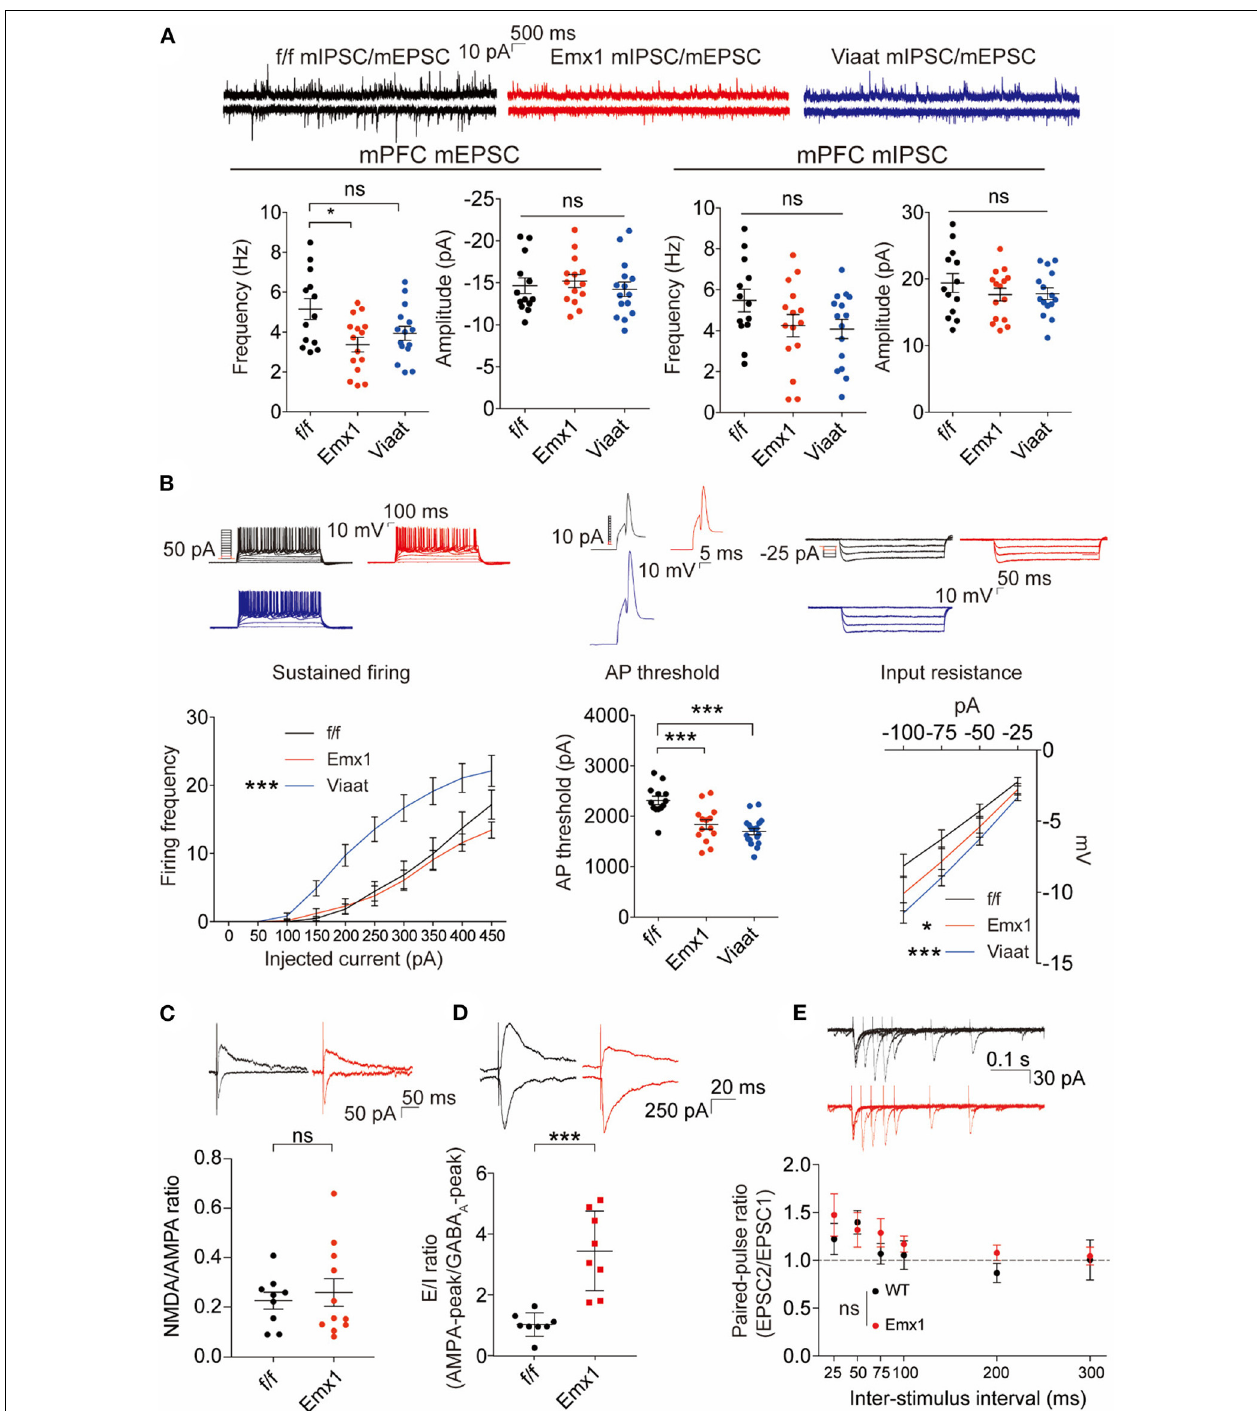
FIGURE 3 | Emx1-Cre;Irsp53 fl / fl and Viaat-Cre;Irsp53 fl / fl mice show distinct changes in synaptic transmission and intrinsic excitability in medial prefrontal cortex (mPFC) pyramidal neurons. (A) Miniature excitatory postsynaptic currents (mEPSCs) and miniature inhibitory postsynaptic currents (mIPSCs) in layer V pyramidal neurons in the prelimbic region of the mPFC in Emx1-Cre;Irsp53 fl / fl and Viaat-Cre;Irsp53 fl / fl mice (3 months; male). Note that the frequency of mEPSCs is significantly decreased in Emx1-Cre;Irsp53 fl / fl mice. n = 13 neurons from three mice for f/f-mEPSC, 14, 3 for Emx1-mEPSC, 15, 3 for Viaat-mEPSC, 13, 3 for f/f-mIPSC, 15, 3 for Emx1-mIPSC, and 15, 3 for Viaat-mIPSC, * P < 0.05, ns, not significant, one-way ANOVA with Bonferroni’s test. mEPSC frequency, F (2,39) = 4.119; mEPSC amplitude, F (2,39) = 0.342; mIPSC frequency, F (2,40) = 2.012; mIPSC amplitude, F (2,40) = 0.7806. (B) Intrinsic excitability in layer V pyramidal neurons in the prelimbic